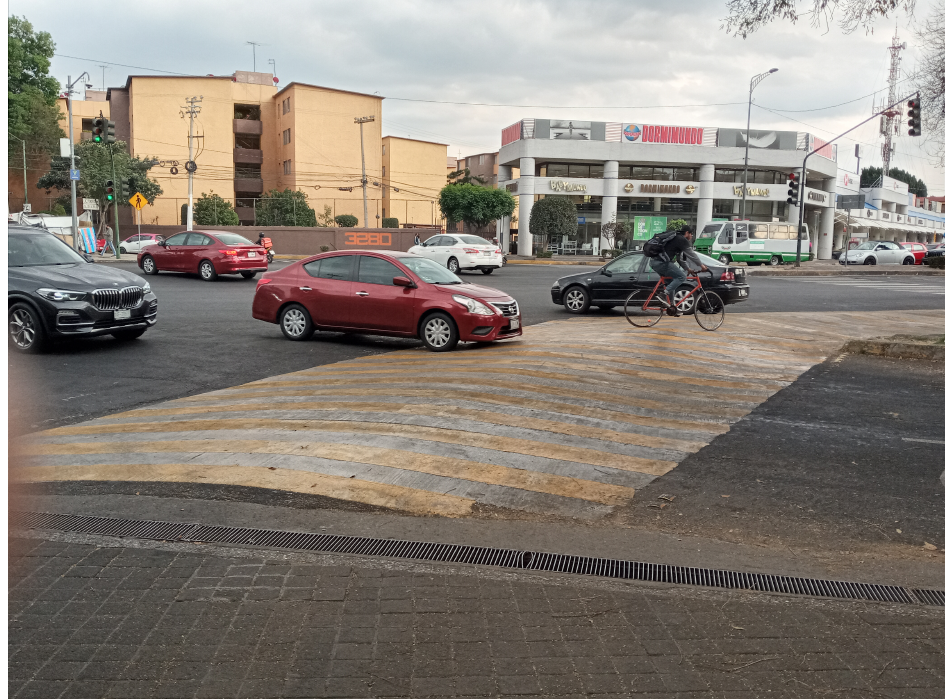
Figure 2. In some places of Mexico City, this huge speed hump is located, which had to be exaggerated in size to force drivers to slow down. Observe the car from a distance and the bicycle on the hump to have an idea of the dimensions of the obstacle. Although this image together with Figure 3 are on-road resources, the possibility of dealing with this in off-road environments for GCs and PSVs cannot be